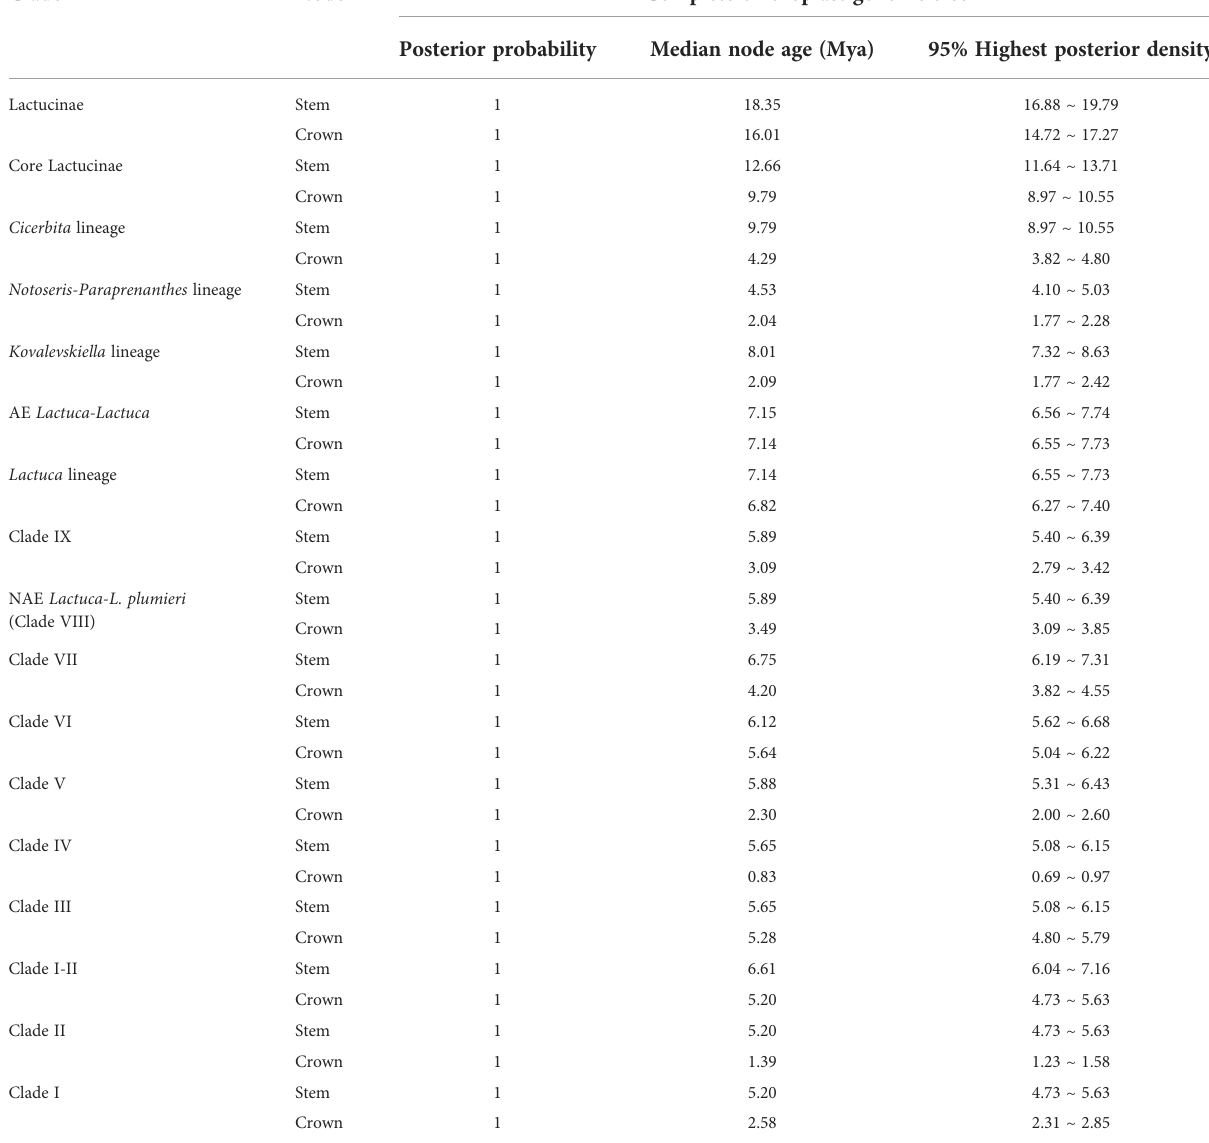
TABLE 1 Estimated divergence time of Lactuca and related genera based on the complete plastome sequences.